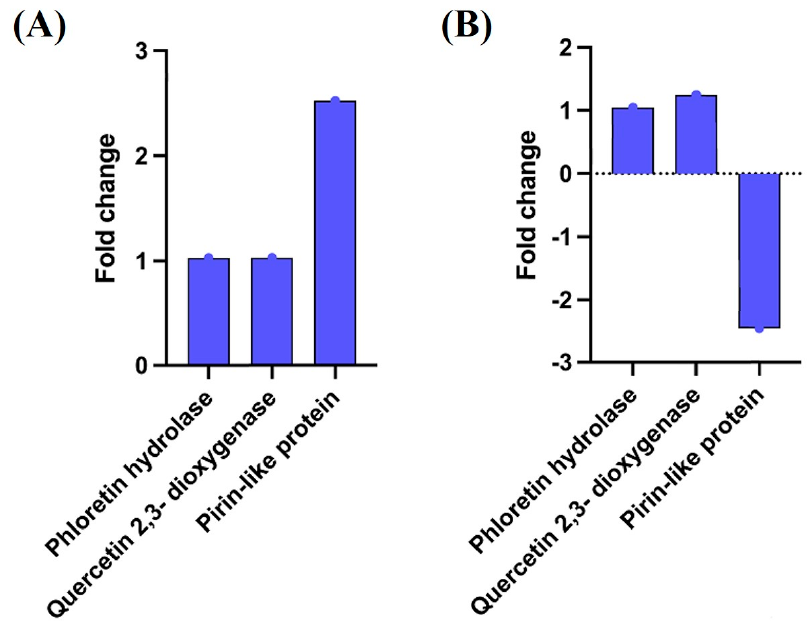
Figure 7. Expression of three different quercetin-degrading enzyme homologs in (A) B.